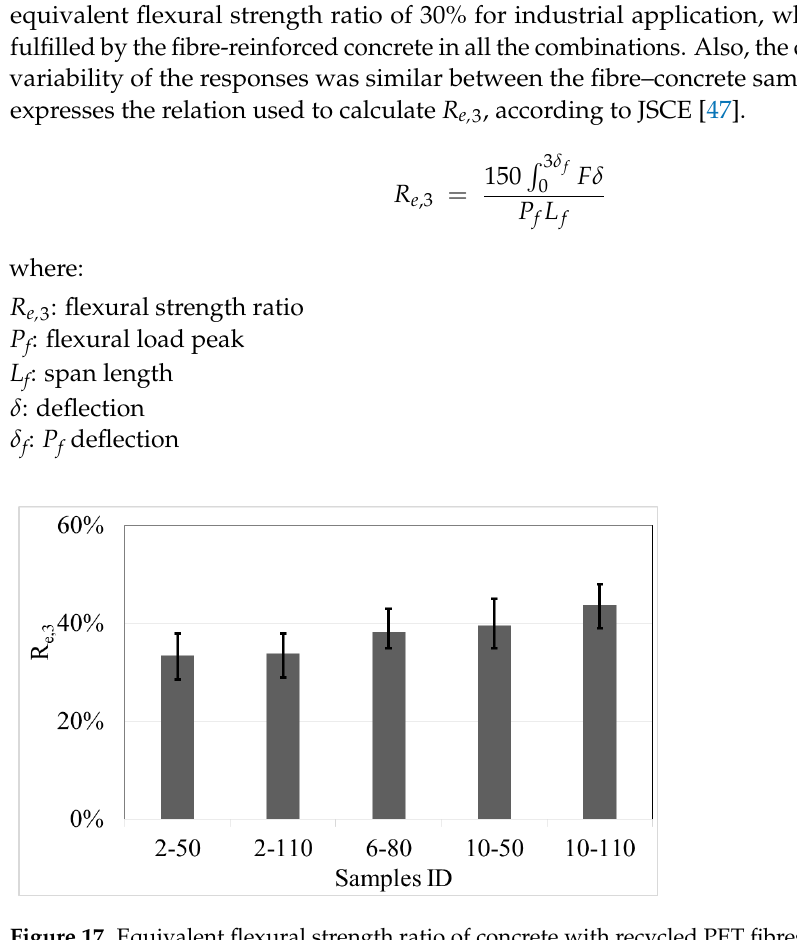
Figure 18 indicates the volumetric weight (V W ) of the control samples and R/PET- FRC concretes, measured according to ASTM C78 [46]. Figure 18. Volumetric weight of control samples and concrete with recycled PET fibres.